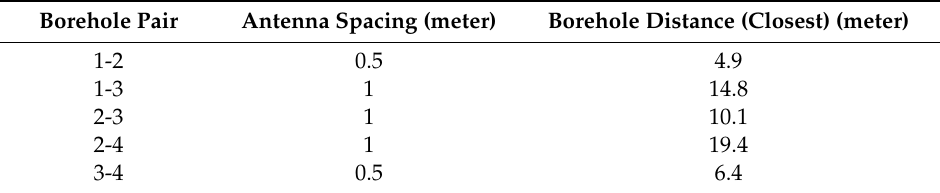
Table 1. Crosshole GPR, data